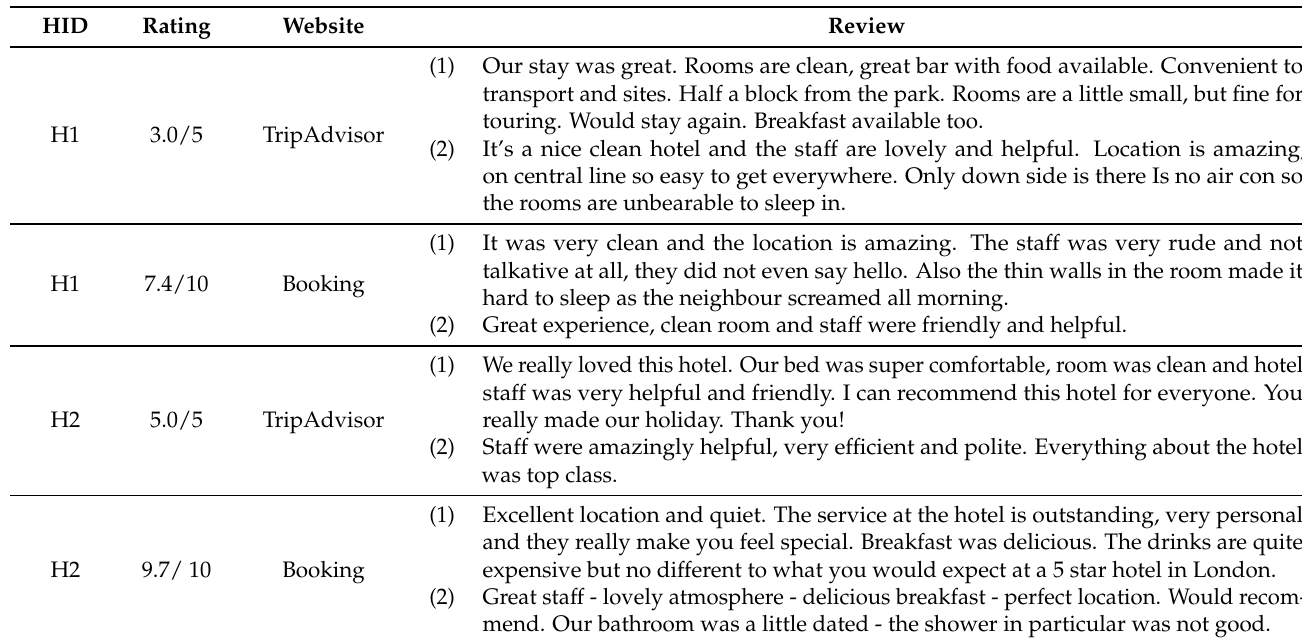
Table 1. A comparative analysis of some reviews of two specific hotels for two different hotel booking websites , i.e., Tri- pAdvisor [8] and Booking